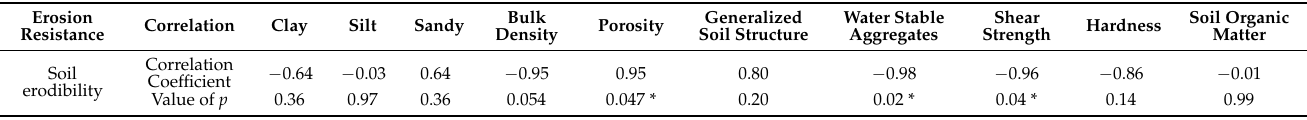
Table 2. Correlation between soil erodibility and soil physical and chemical properties under freeze-thaw conditions. Erosion